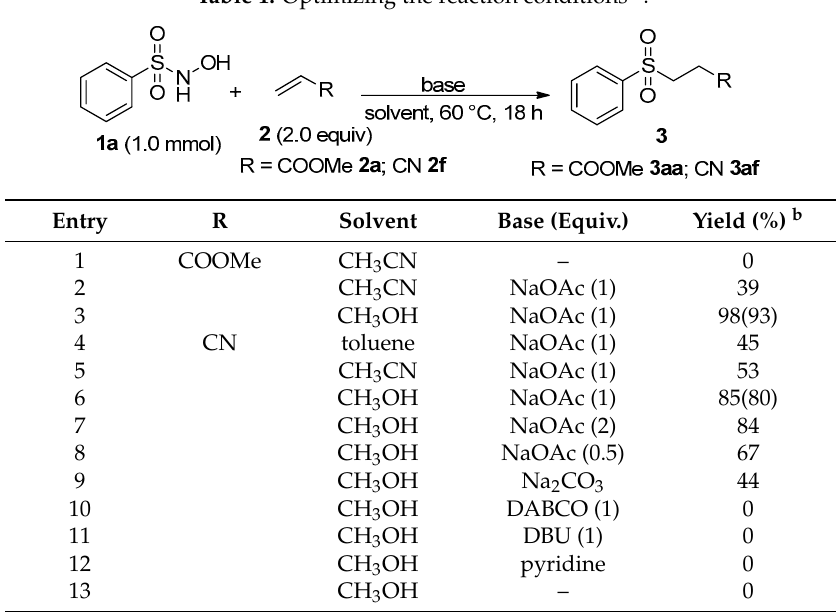
Table 1. Optimizing the reaction conditions a .